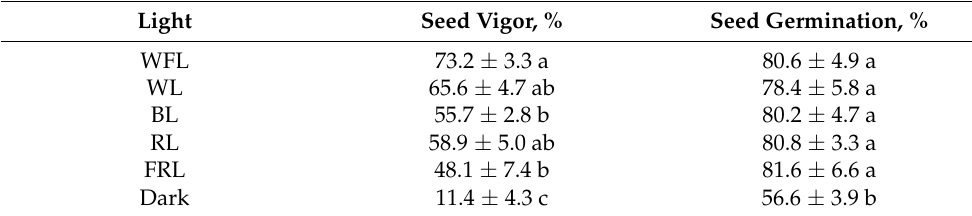
Table 1. Effect of light quality on the vigor and germination of Scots pine